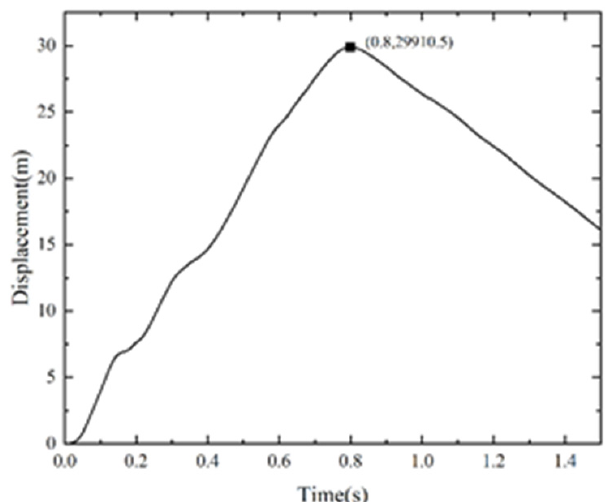
Figure 15. Displacement of tractor rocket.